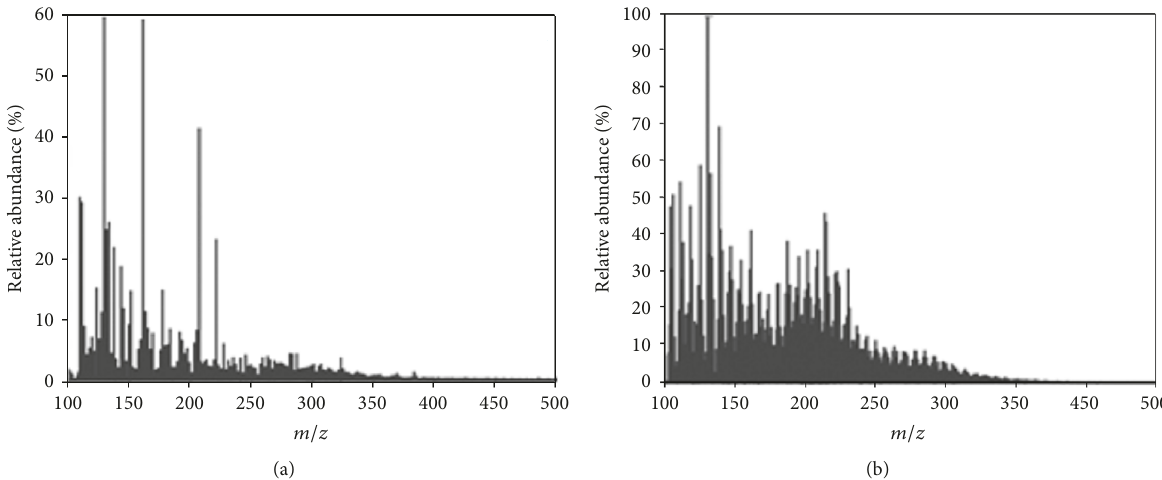
Figure 6: Negative-ion ESI-MS (a) and negative-ion APCI-MS spectra (b) of pyrolysis biooil (Orbitrap Elite; m / Δ m 50 = 480,000 at m / z 400) [30].